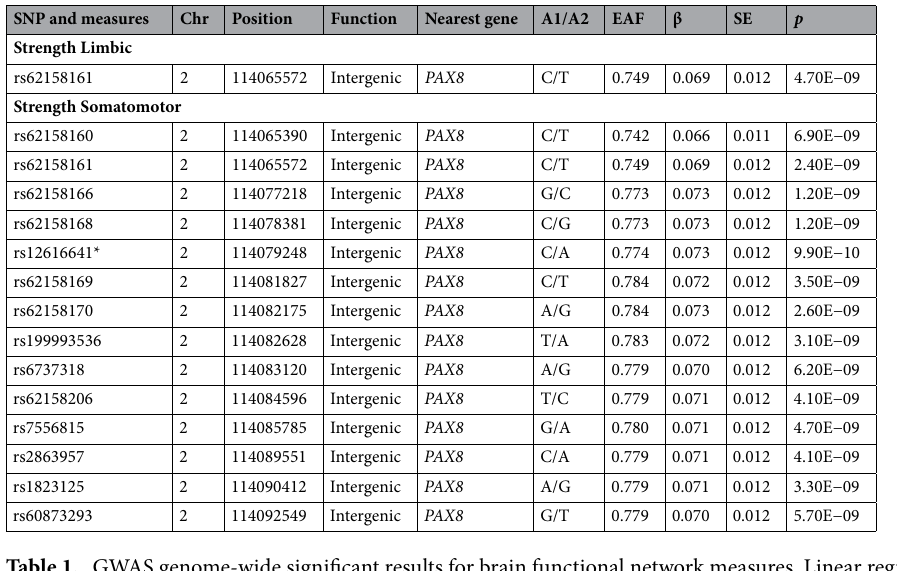
Table 1. GWAS genome-wide significant results for brain functional network measures. Linear regression models were adjusted for age, age 2 , sex, age × sex, age 2 × sex, head motion from resting-state fMRI, head position, volumetric scaling factor needed to normalize for head size, and 10 genetic principal components. P values are two-tailed. Only results that survived Bonferroni correction ( p < 5 × 10 –8 /6) were reported